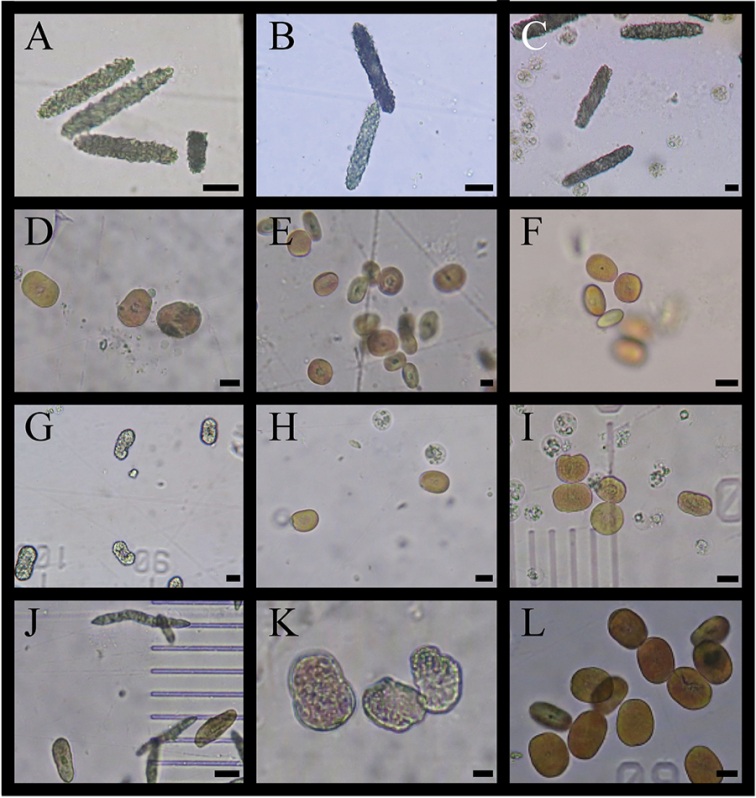
Sclerites of Xeniidae. AAntheliacf.glaucaBA.roseaCA.cf.tosanaDHeteroxeniacf.elisabethaeEH.medioensisFH.minutaGSympodium. sp. 1 HS. sp 2. IYamazatum sp. 1 JXenia sp. 1 KX. sp. 2 LX.plicata. Scale bars: 10 μm.